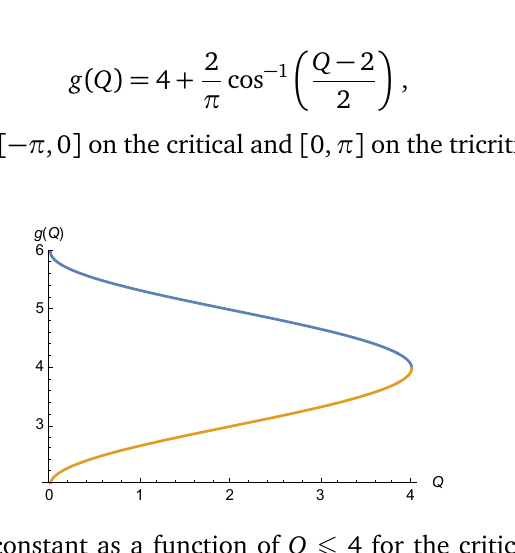
Figure 3: Coupling constant as a function of Q (cid:54) 4 for the critical (lower branch, orange) and tricritical (upper branch, blue) Potts model.